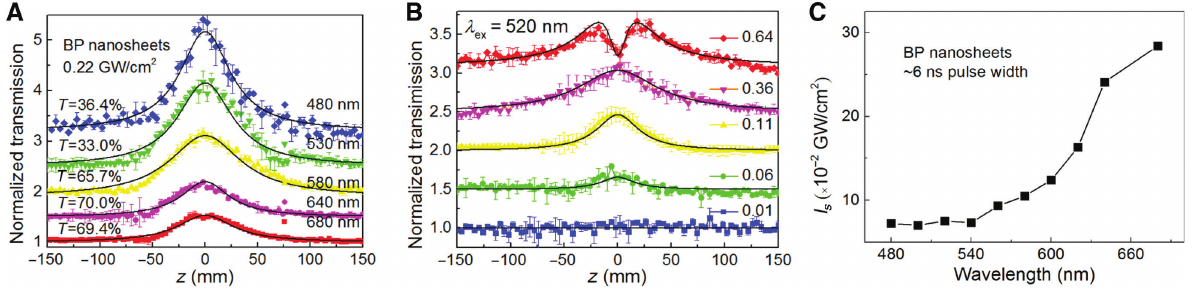
Figure 5: Nanosecond open-aperture Z scan measurement for BP nanosheets. (A) Nanosecond open-aperture Z scan measurement under different wavelengths in the visible region. (B) Fluence-dependent open-aperture Z scan measurement at 520 nm. The fluence changes from 0.01 GW/cm 2 to 0.64 GW/cm 2 . The black solid lines are the fitting curves. (C) Wavelength-dependent saturation intensity at 0.22 GW/cm 2